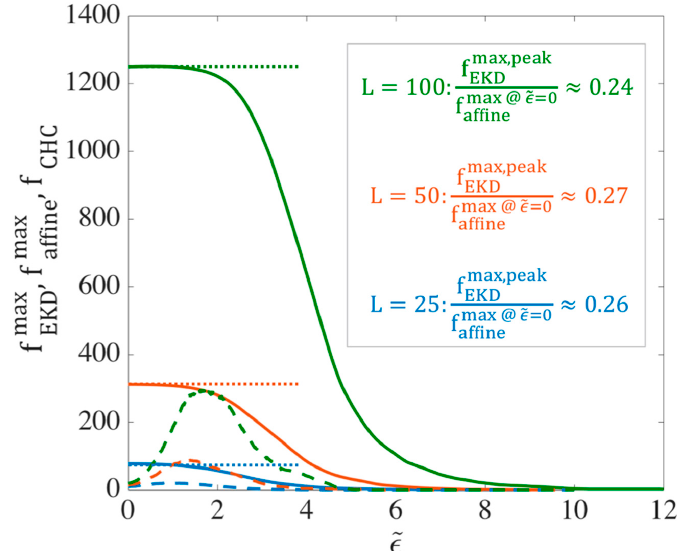
Figure 3. Evolution of the ensemble-averaged maximum kink force ( f max ) for different chain lengths L = 25 (blue), L = 50 (orange), and L = 100 (green) at asymptotically high strain rates. For each length, the ensemble averaged force is shown for both affine motion of kinks (solid lines) and EKD simulations with ρ 0 = 0.8 (dashed lines). The horizontal dotted lines give the maximum possible force, f CHC at an entangled kink for each chain length, obtained from Equation (7) as discussed in the text. The units of the force are set by the parameter values ζ (cid:48) = ˙ (cid:101) = 1; i.e., the dimensional force is obtained by multiplying the plotted force by ζ (cid:48) ˙ (cid:101) times the square of the unit of